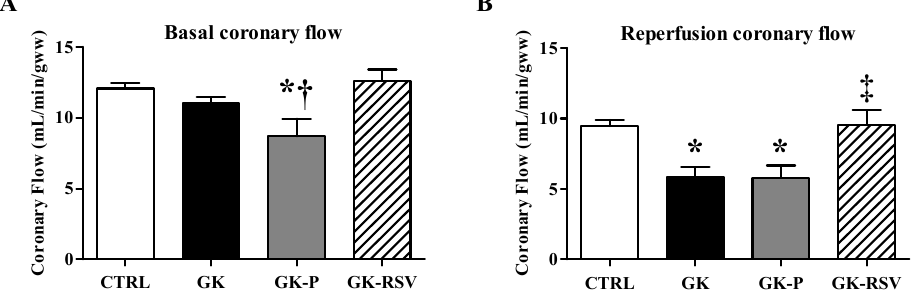
Figure 4. Baseline coronary flow evaluated at 20 min ( A ) and reperfusion coronary flow evaluated at 80 min ( B ). Data are expressed as means ± SEM and one-way ANOVA was used to compare the groups. * p < 0.05 vs. CTRL, † p < 0.01 vs. GK-RSV, and ‡ p < 0.05 vs. GK and GK-P.